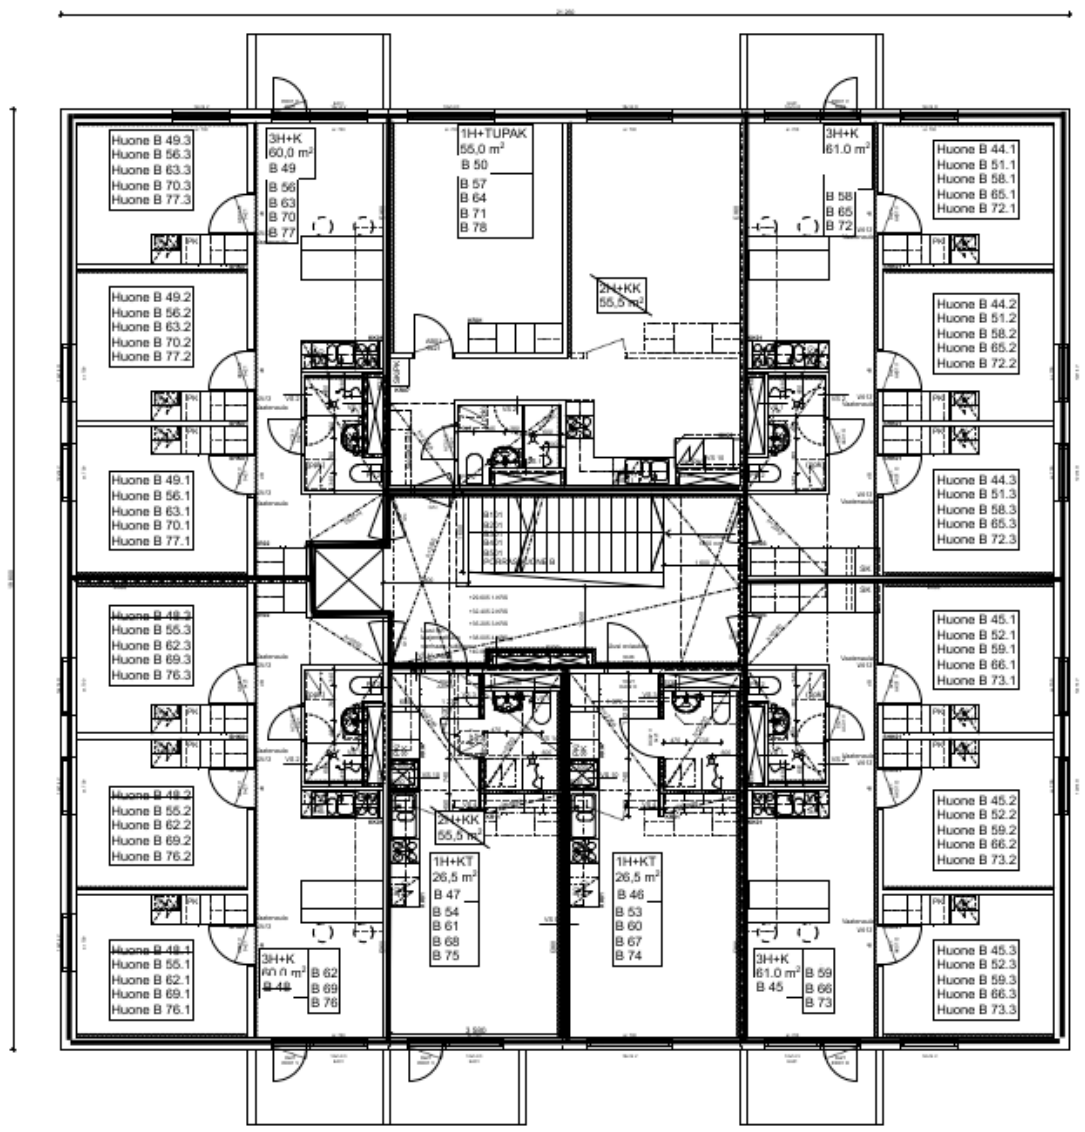
Figure 2. Floor plan of a residential floor of the case site.